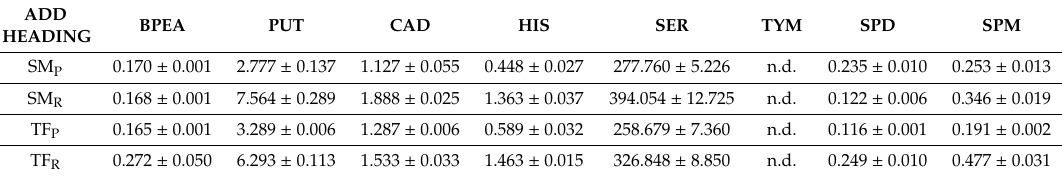
Table 7. Biogenic amines determined by HPLC in SM and TF samples, at red and pink ripening stages ± Std. Dev. ( µ g / g) a .